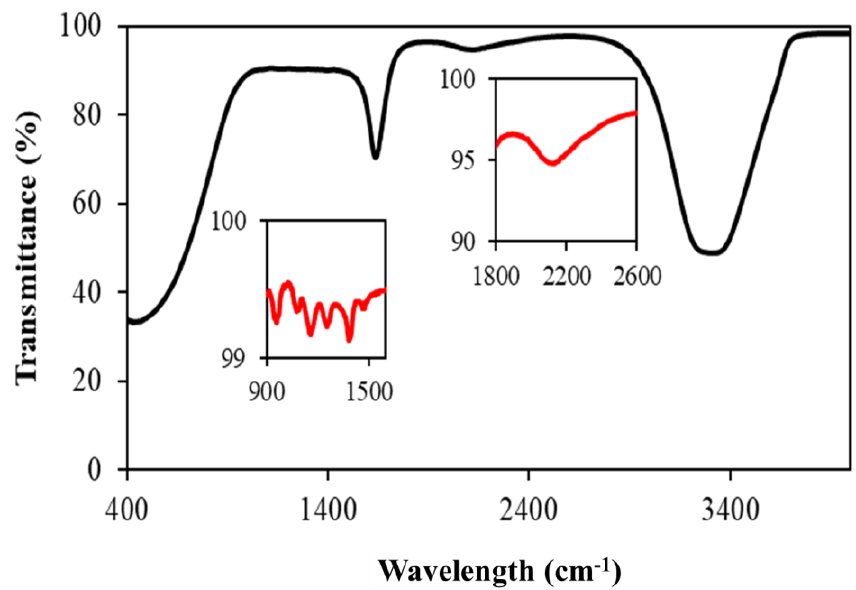
Figure 4. FTIR analysis of silver nano ink used for printing on the cyclic olefin polymer surface. FTIR analysis of the dried AgNPs was provided as the inset.